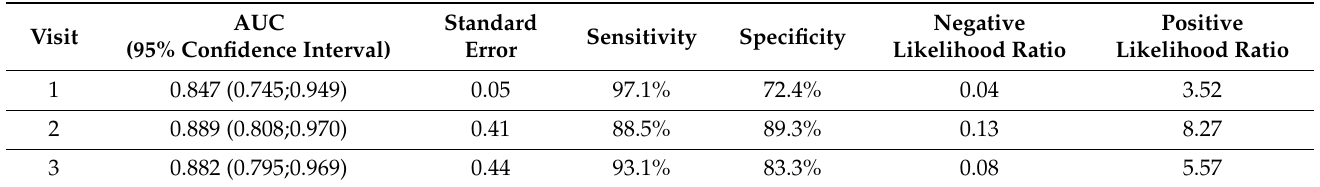
Table 3. Area under the ROC curve (AUC), sensitivity, specificity and likelihood ratios for Cis findings based on visual activity assessment as the reference standard.